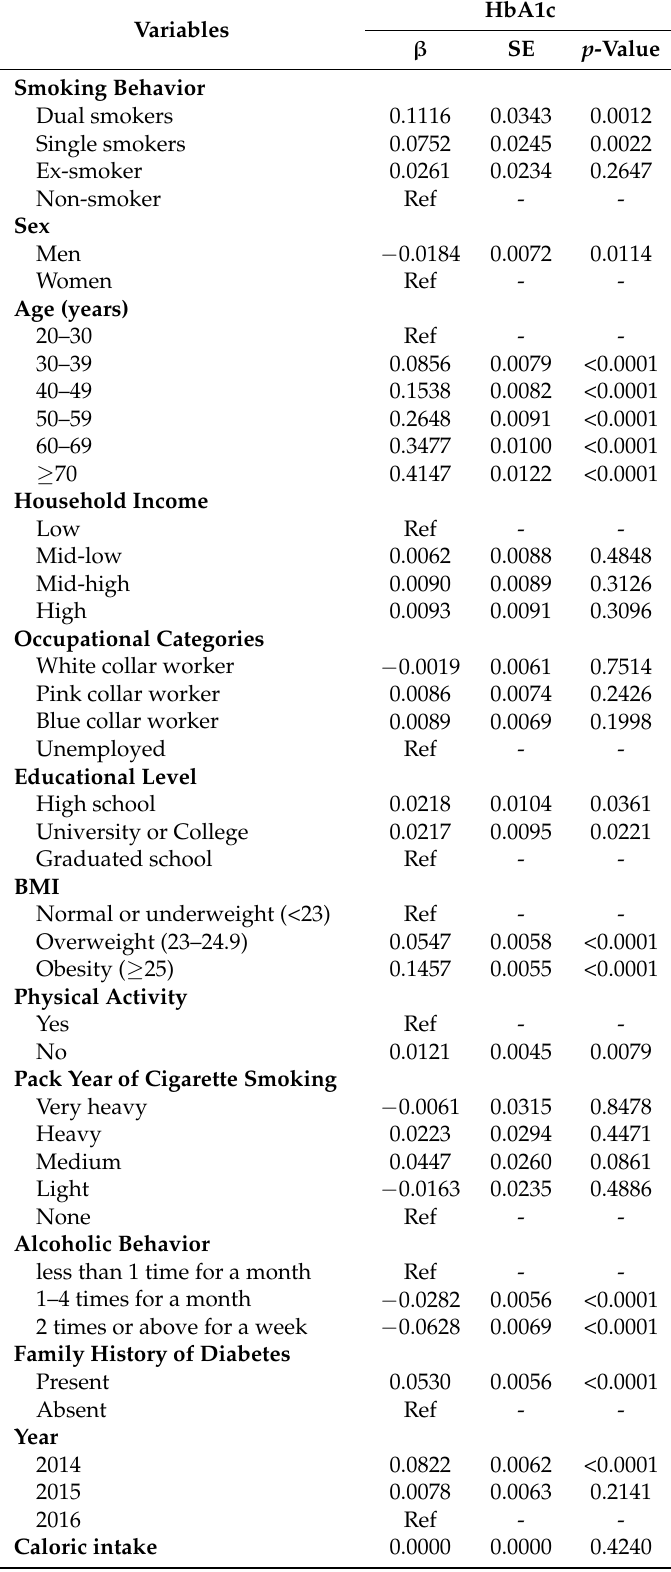
Table 2. The results of multiple regression analysis to investigate the association between smoking behavior patterns and